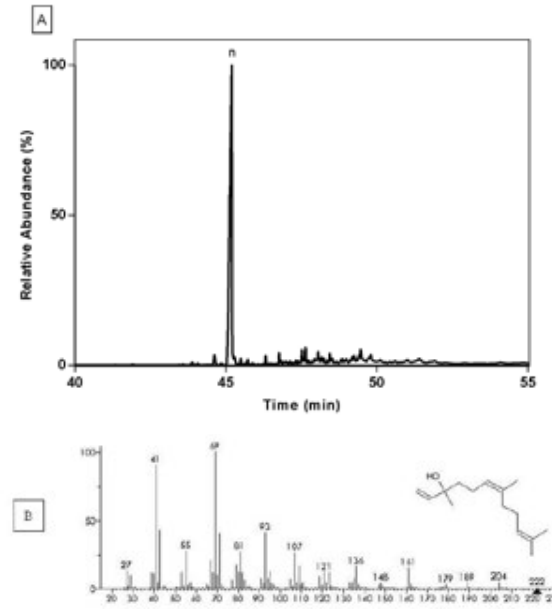
Figure 5. (A) TIC of cell suspension cultures inoculated with Pm. parasiticum and analyzed 8 h after application of [ 1-3 H]-FPP; the peak at 45.20 min was identified as nero - lidol (n). (B) MS spectra of nerolidol.